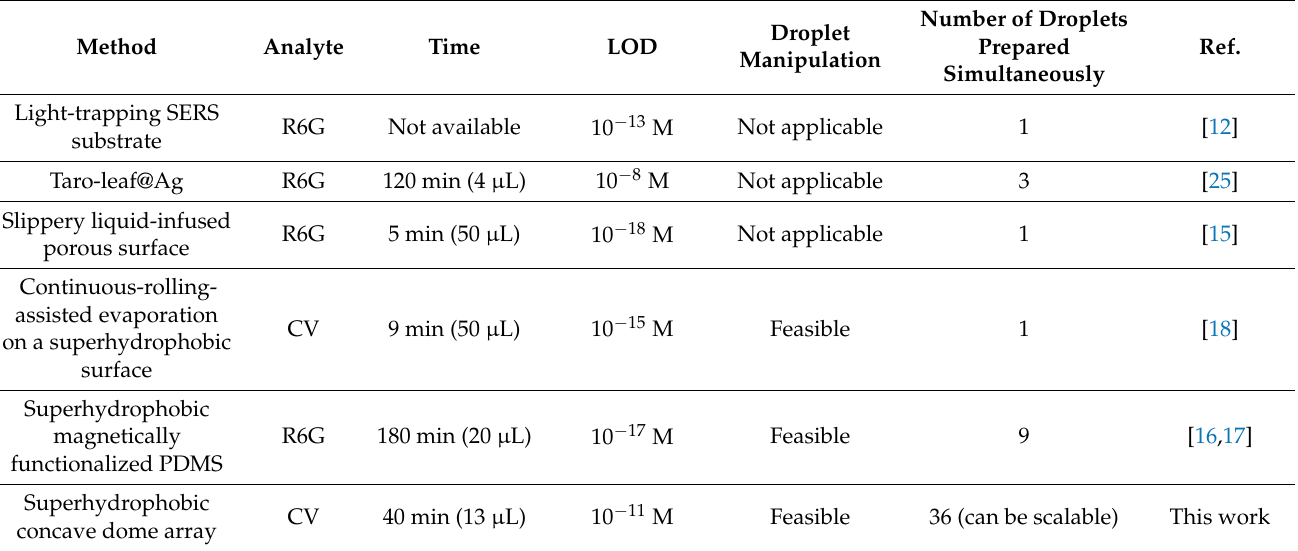
Table 1. Comparing performance of SERS substrates with other reported